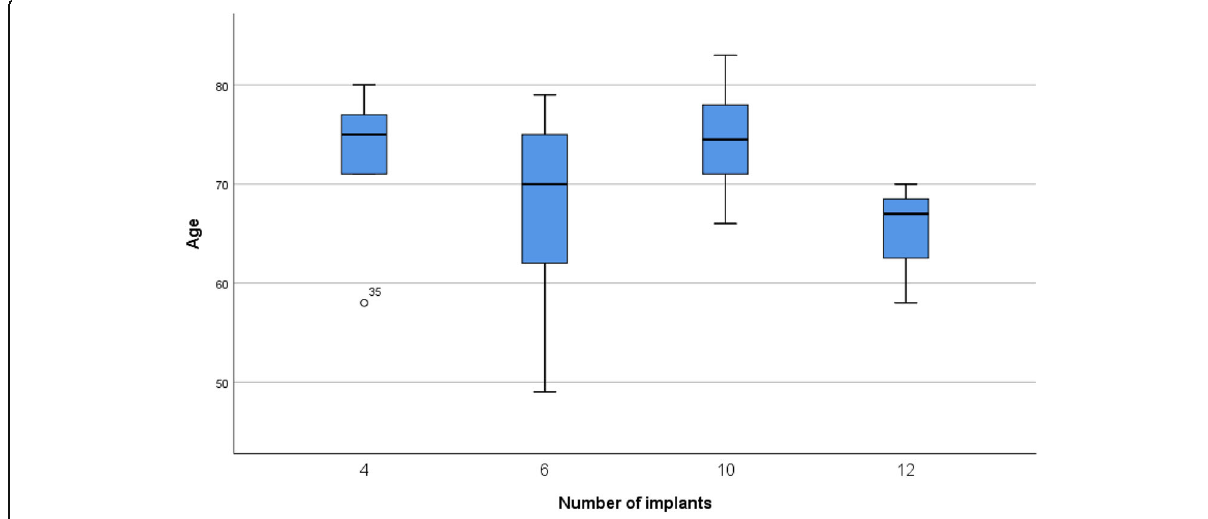
Fig. 2 Distribution of age by number of implants